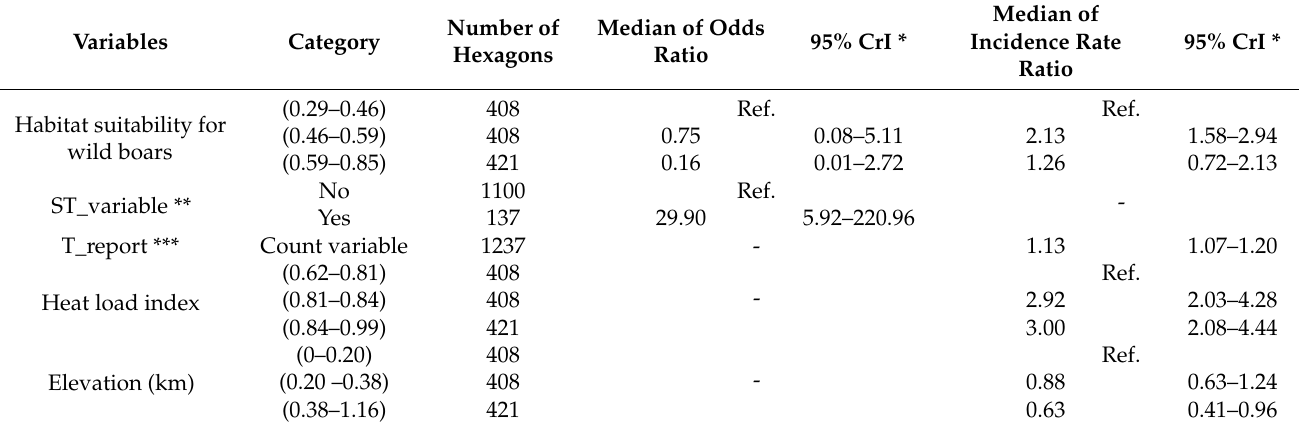
Table 3. Results of the spatial zero-inflated Poisson model for the second period (from 19 January 2020 to 28 April 2020).